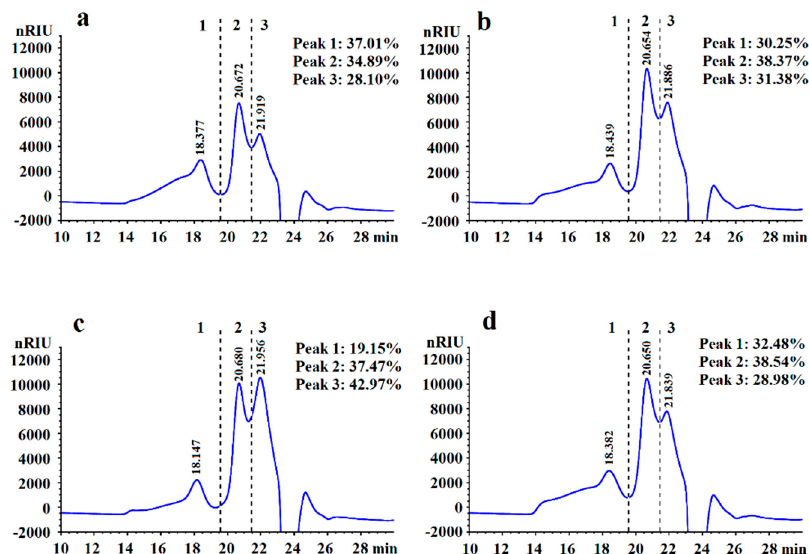
Figure 1. High-performance gel permeation chromatography (HPGPC) chromatogram of LVPs extracted by different methods: ( a ) LVP-u; ( b ) LVP-m; ( c ) LVP-e; ( d ) LVP-h. Elution time for different molecular weight fractions (fraction 1: Mw > 75 kDa; fraction 2: 75 kDa > Mw > 10 kDa; fraction 3: Mw < 10 kDa) are shown.